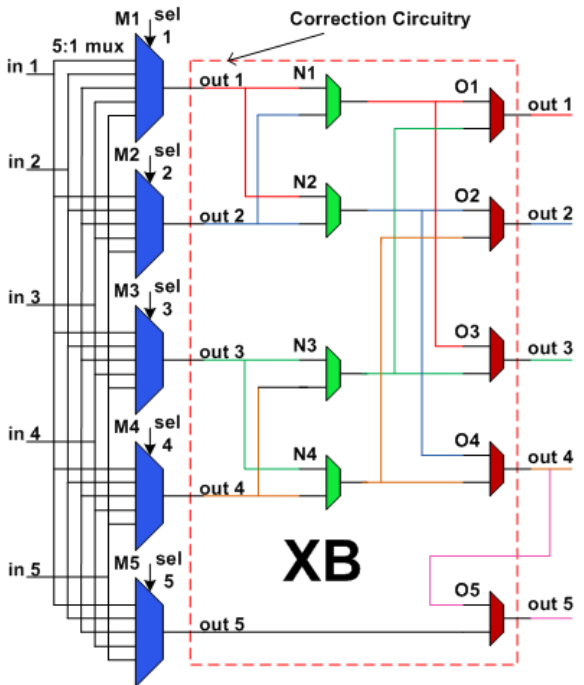
Figure 8. Fault-Tolerant XB Unit